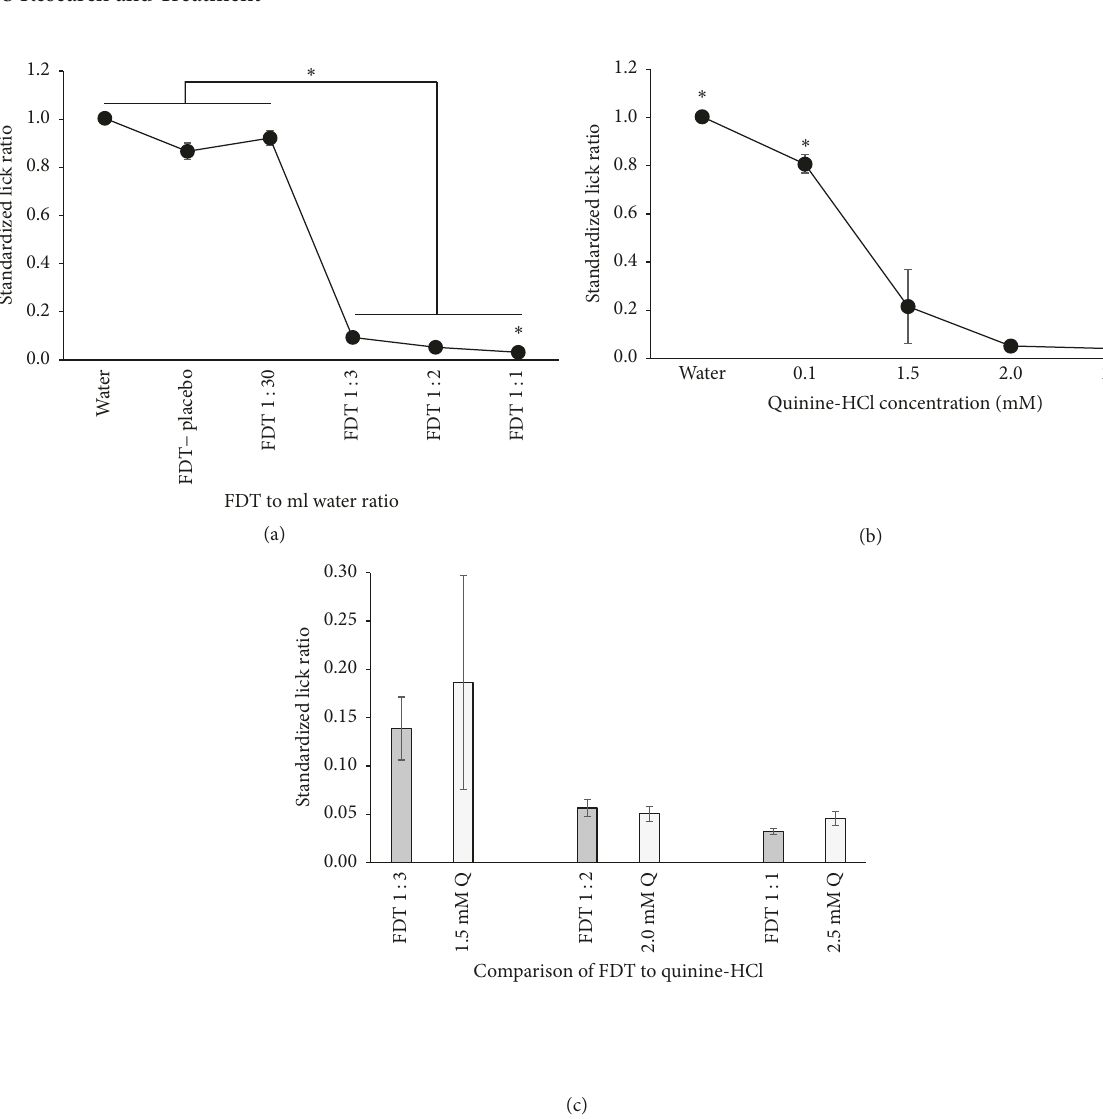
Figure 1: Average licks to stimuli normalized to licks to water in water-restricted rats ( 𝑛 = 13 ) with SEM represented in errors bars. (a) Stars representsignificant differences ( 𝑝 < .01 ) inlicking to water andbody-weight-adjusted FDT+(FDT1: 30)compared withconcentrated FDT+ ratios of tablets dissolved in mL water with FDT 1 :1 having significantly less licks than all stimuli. (b) Stars represent significant differences ( 𝑝 < .01 ) in licking to water and increasing concentrations of quinine-HCl. (c) A comparison of licking to concentrated FDT+ and high concentrations of quinine